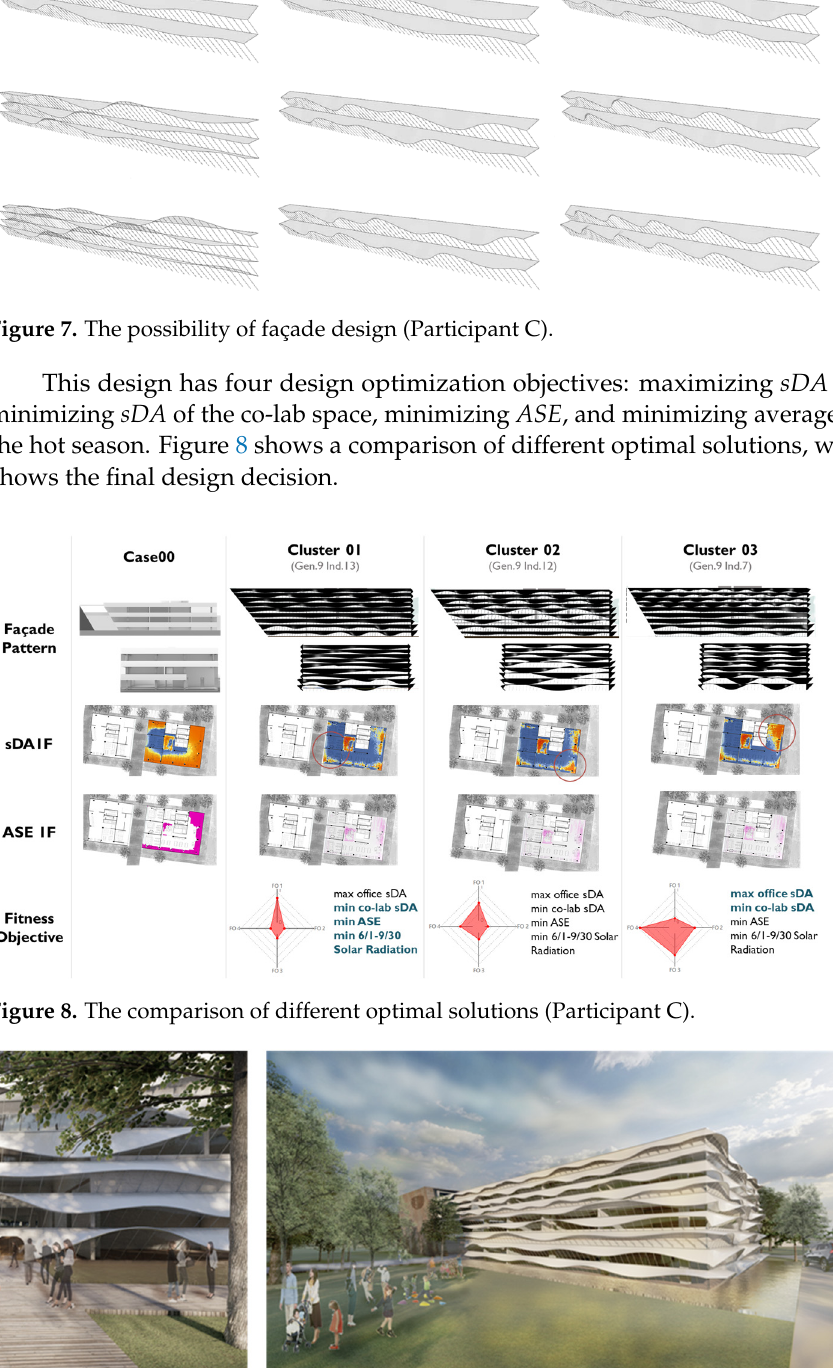
12 of 17 Figure 5. The comparison of different optimal solutions on radiation performance. Figure 6. The final decision façade of headquarters (Participant A).